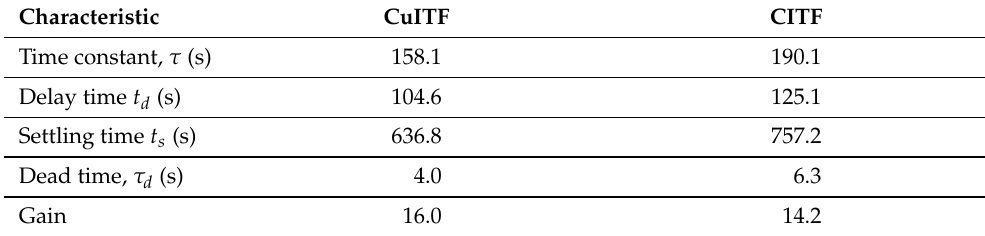
Table 2. Main characteristics of the furnaces.